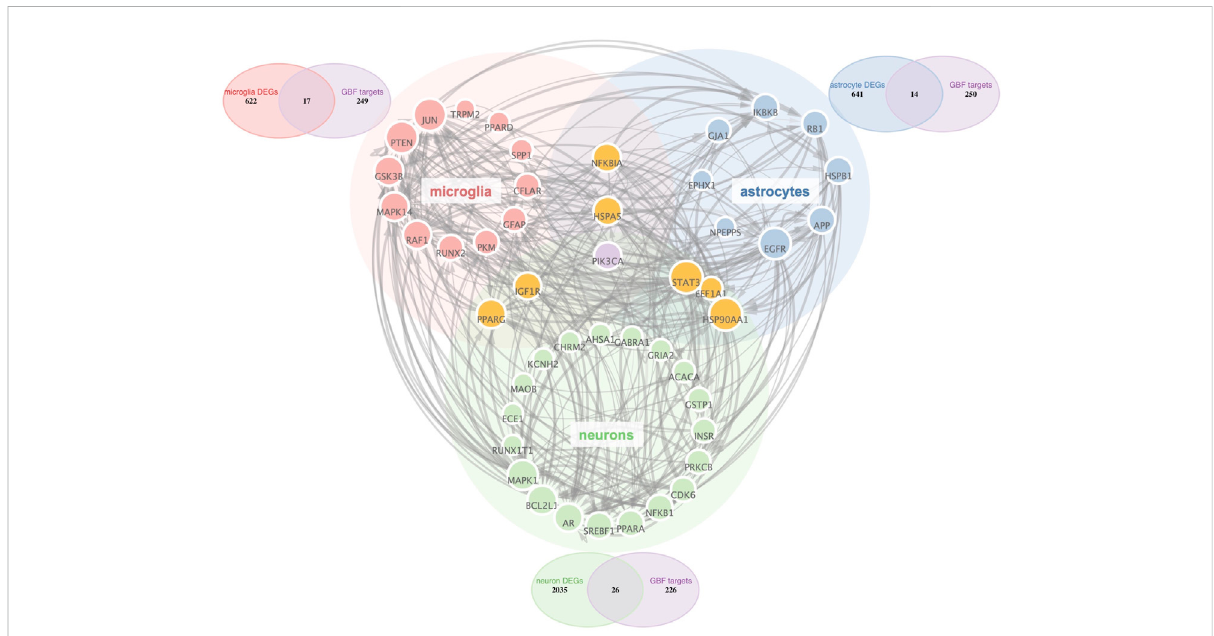
FIGURE 2 PPINetworkanalysisofpotentialGBEtargetsforPD.AllGBEtargetsforPDinmicroglia,neurons,andastrocyteswereidenti fi edviaPPINetwork. Node size was positively correlated to the degree score. The thickness of the edges indicated the connectivity score between linking nodes. Three Venn diagrams showed cell-type-speci fi c targets in the intersection between PD-related targets and GBE targets.